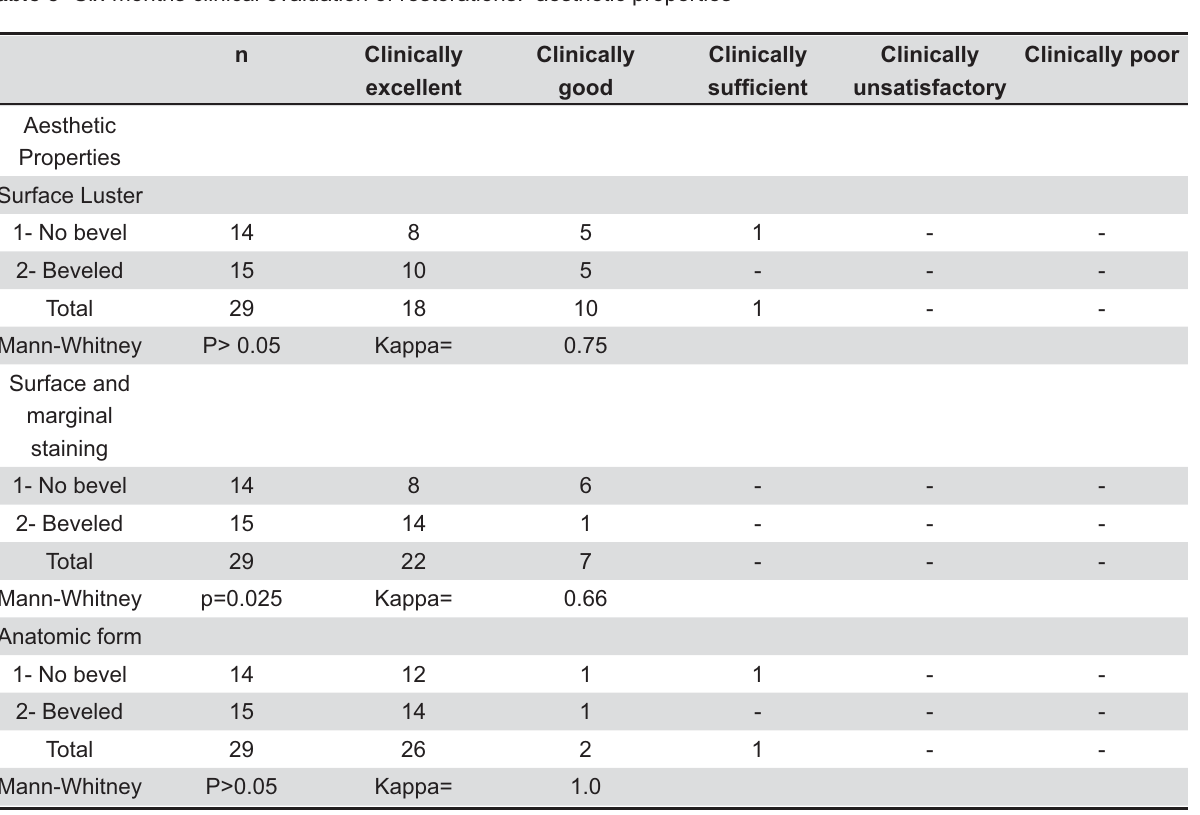
Table 5- Six-months clinical evaluation of restorations: aesthetic properties